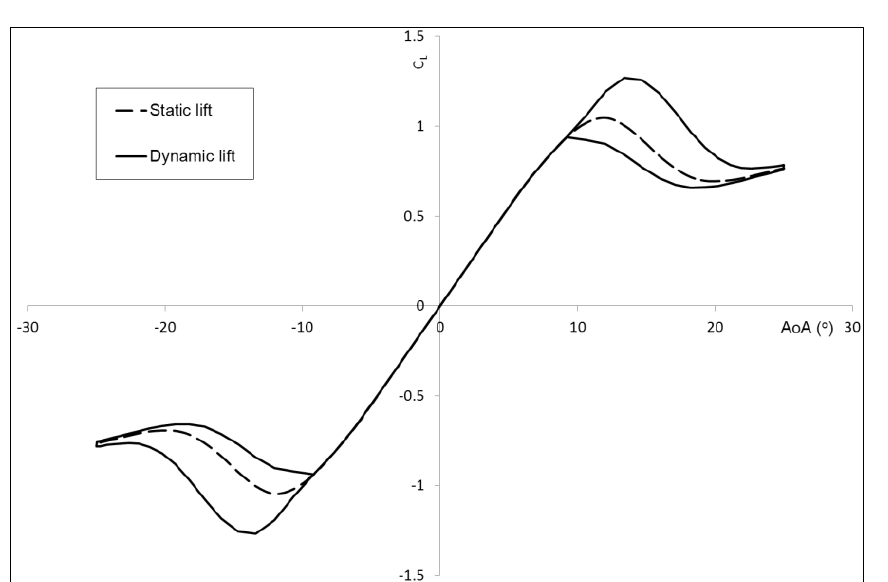
Figure 4. Typical hysteresis response of dynamic